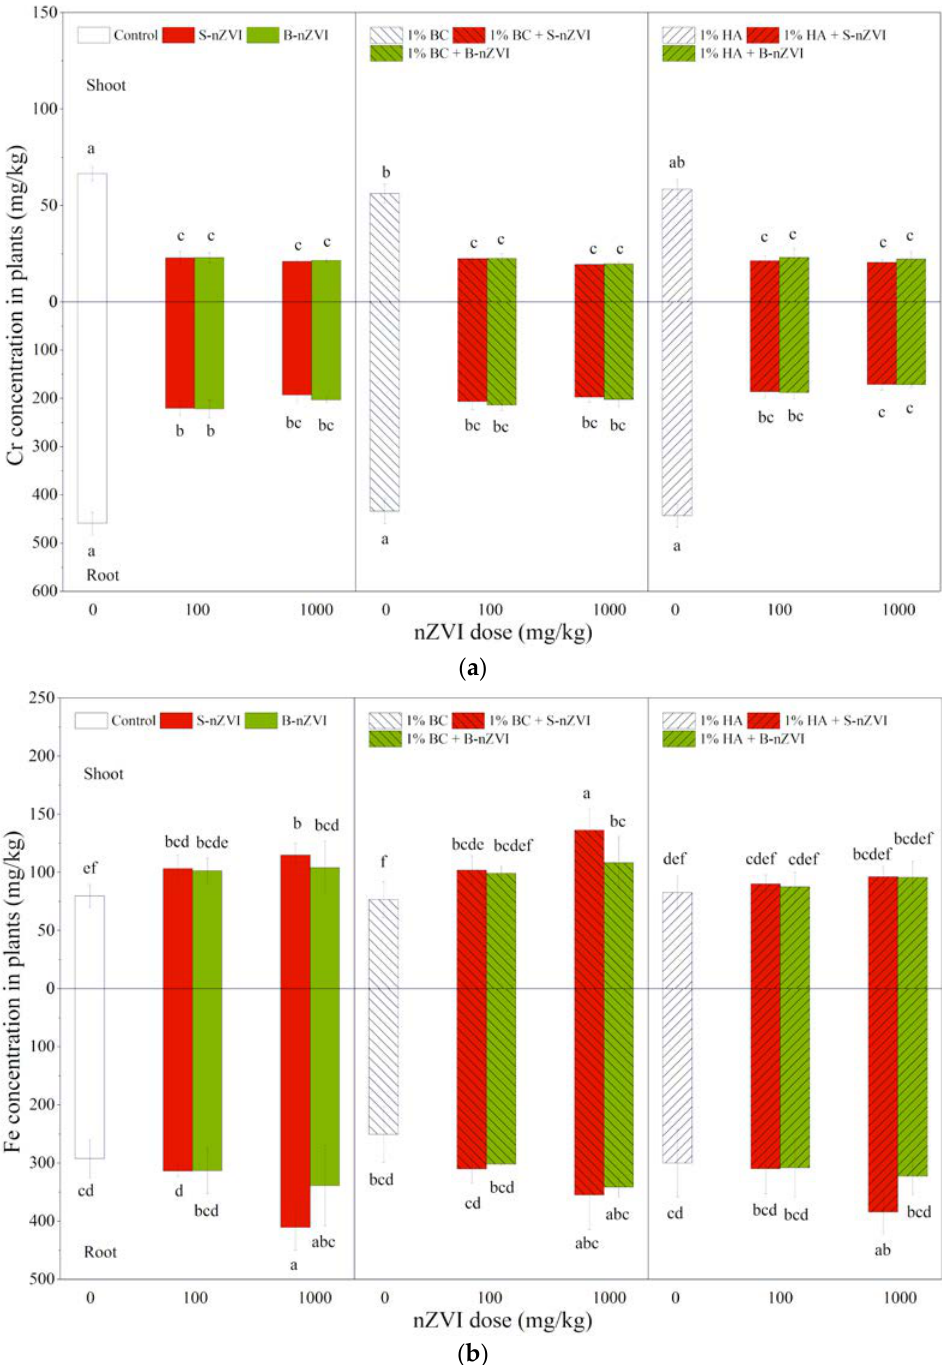
Figure 6. Cr ( a ) and Fe ( b ) concentrations (means ± SD, n = 4) in shoots (above X -axis) and roots (below X -axis) of mung bean seedlings exposed to nZVI alone or in combination with BC or HA. Different letters on the bars indicate significant differences among all means in different treatments using a one-way ANOVA followed by a Duncan’s multiple range test ( p < 0.05). Three-way ANOVA results are shown in Table 2.